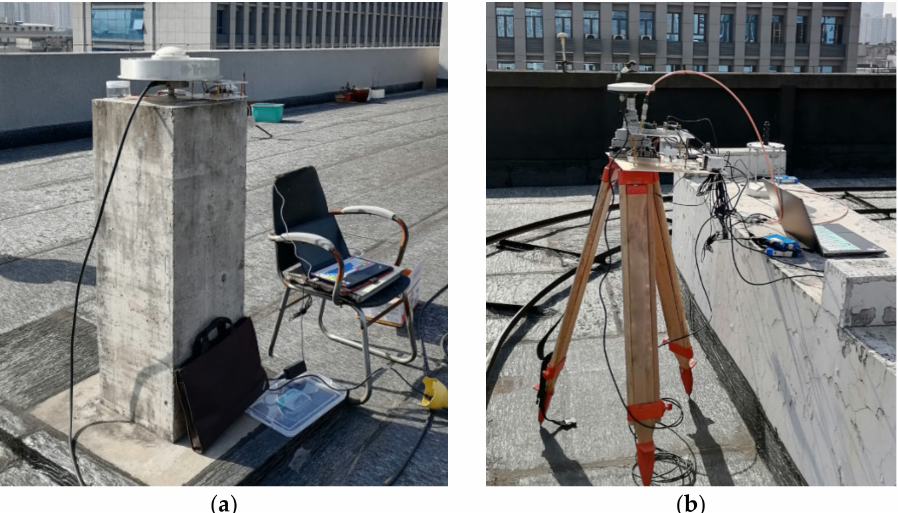
Figure 4. The GNSS RTK/UWB/DBA fusion static positioning experiment site: ( a ) reference station; ( b ) static experiment mobile station.